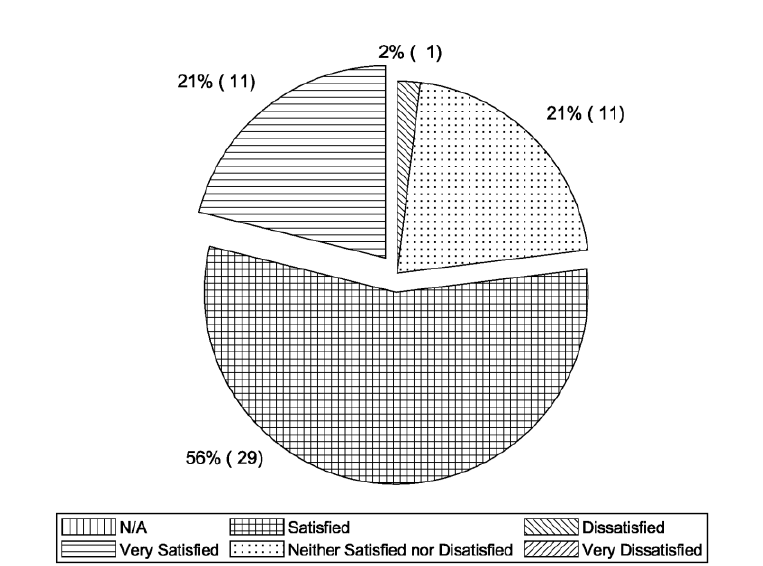
Fig. 16. Overall satisfaction of the students with the